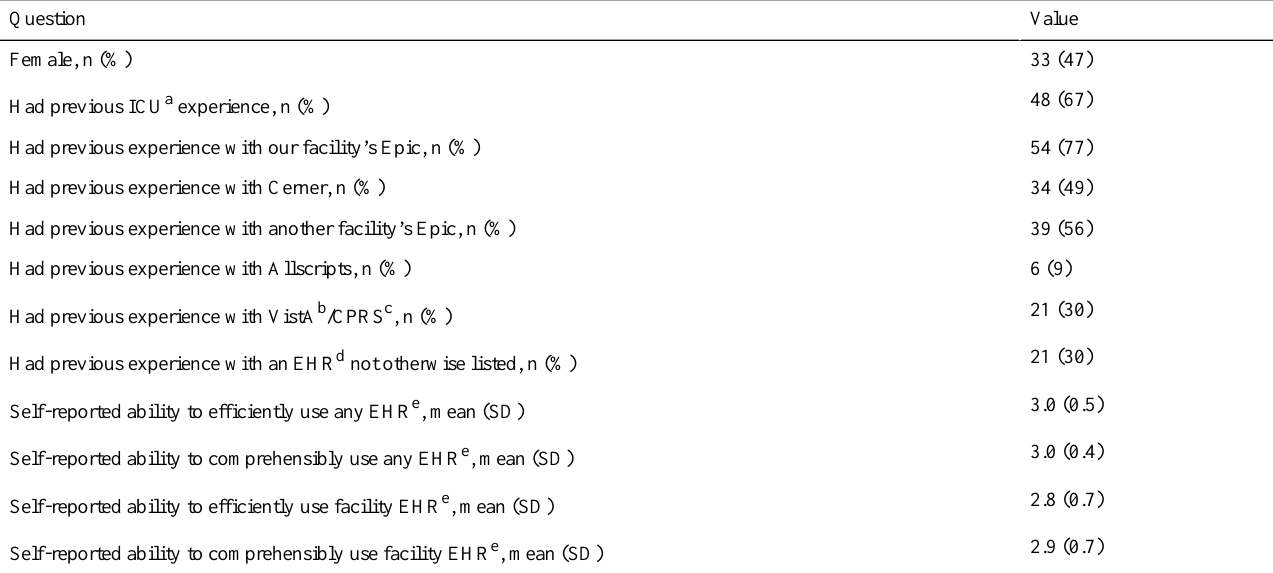
Table 1. Background data on first-year residents undergoing educational activity.